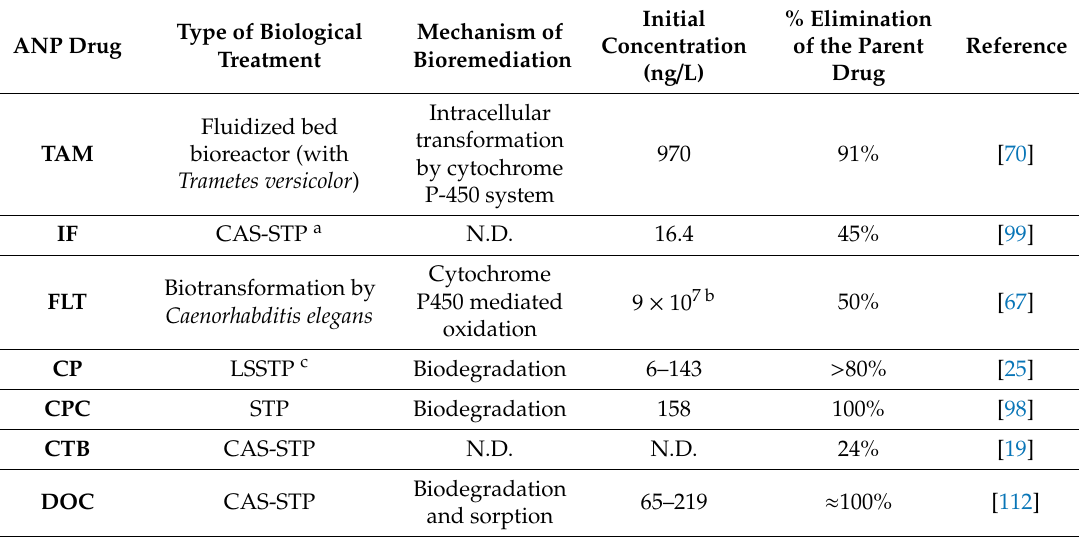
Table 3. Biological degradation of some widely used ANP